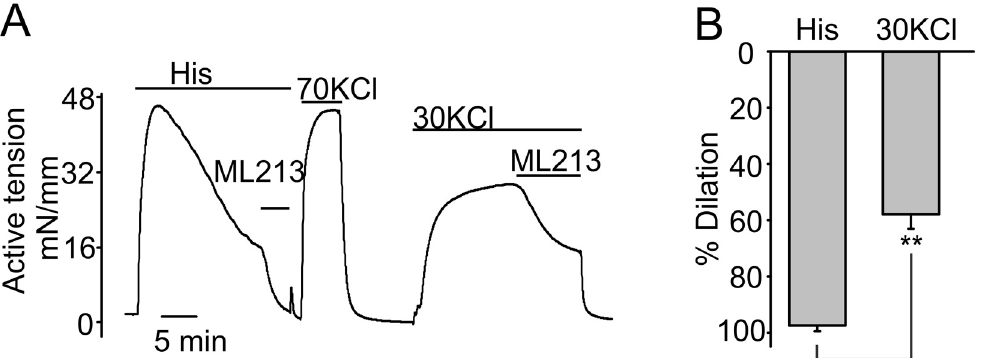
Fig 3. Effects of ML213 on KCl-pre-contracted CAs. A, Sample isometric tension recoding illustrating the effects of 10 μ M ML213 on the rings pre- constricted with histamine or 30 mM KCl. B , Summary data for ML213 effects in pre-contracted CA rings.